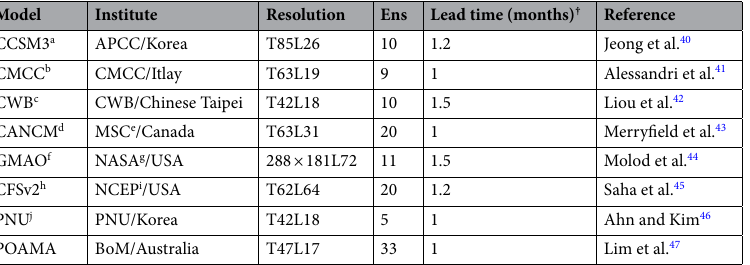
Table 1. Description of 8 dynamical seasonal climate prediction systems used in PICASO. a Community Climate System Model Version 3. b Centro Euro-Mediterraneo sui Cambiamenti Climatici. c Central Weather Bureau of Chinese Taipei. d Canadian Centre for Climate Modeling and Analysis Coupled Climate Model. e Meteorological Service of Canada. f Global Modeling and Assimilation Office. g National Aeronautics